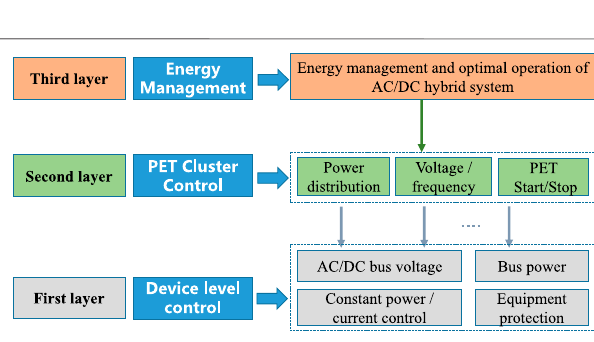
FIGURE 3 | Hierarchical control system of AC/DC hybrid power